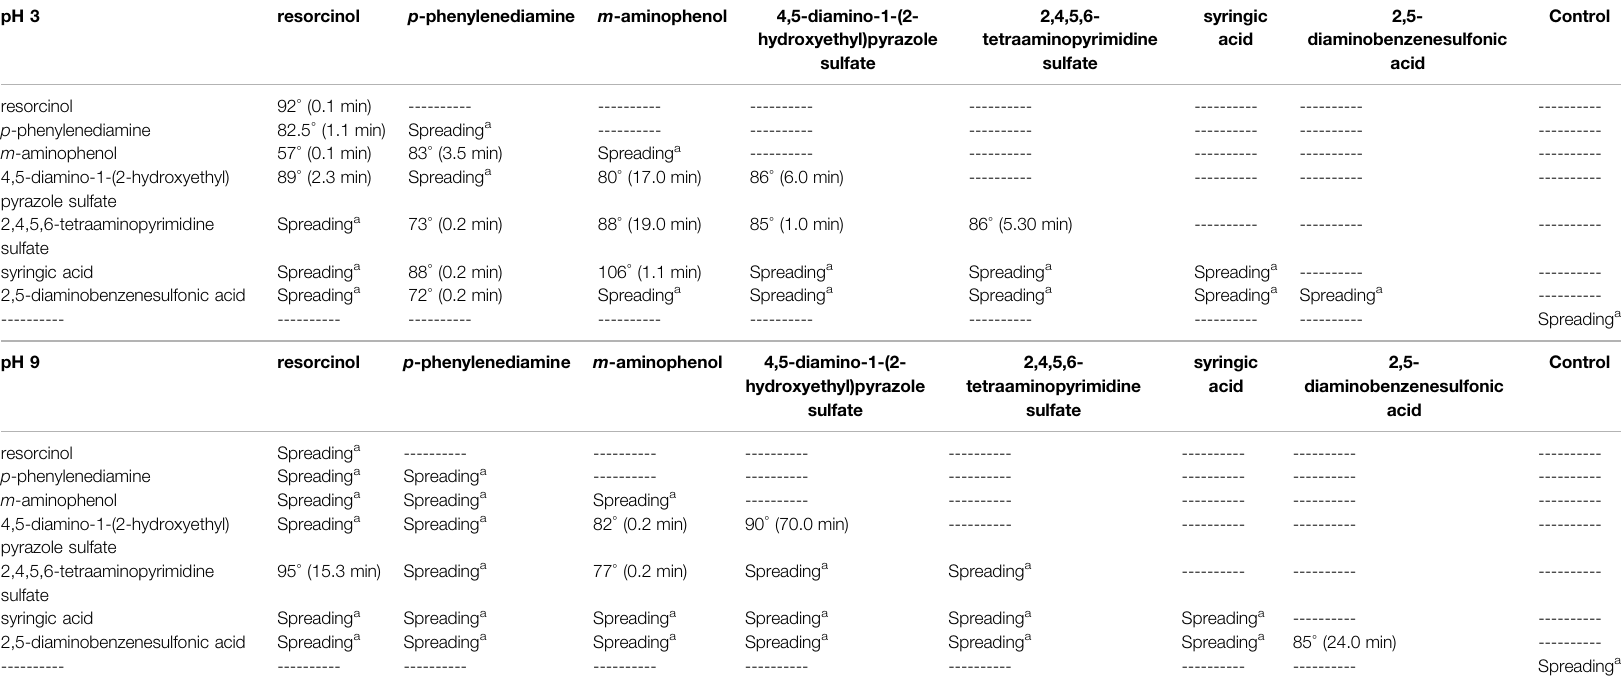
a Spreading: the water droplet is completely spread out/absorbed on the solid surface. The standard deviation for each sample was less than